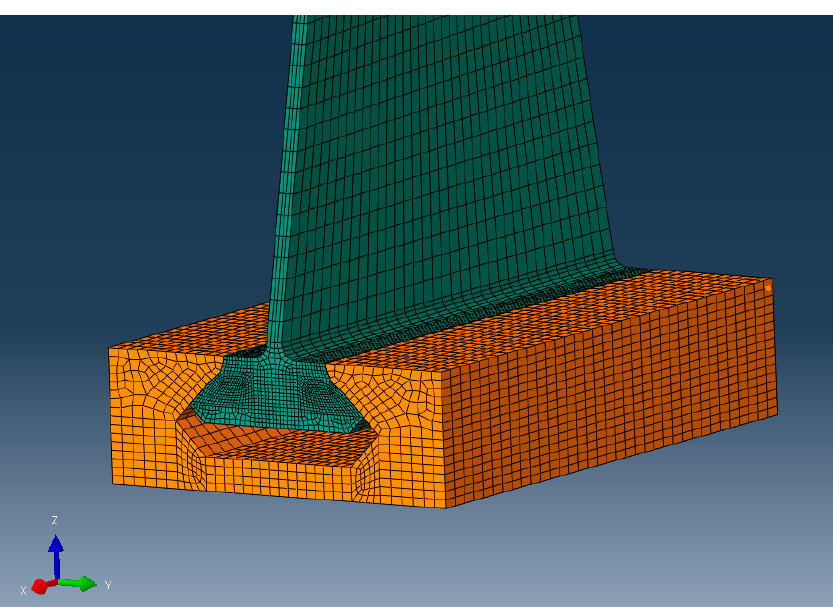
Figure 1. A dovetail joint between the compressor-blade-like structure and the disc representative geometry.